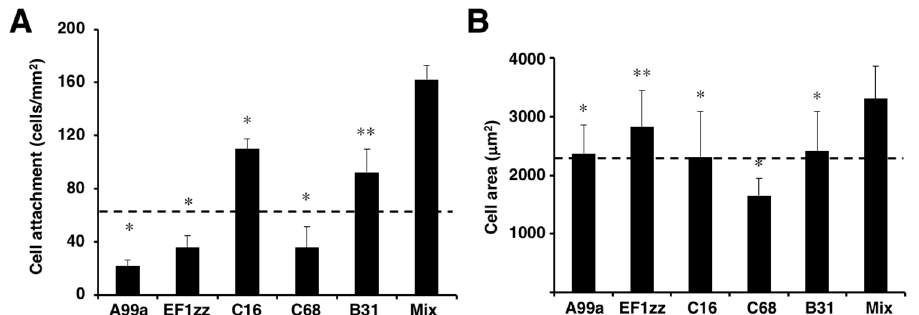
Figure 5. HDF attachment and spreading activity of peptide–chitosan matrices mimicking LM-111. CGG-A99a, CGG-EF1zz, CGG-C16, CGG-C68, and CGG-B31 (derived from LM-111, 10 nmol/well)